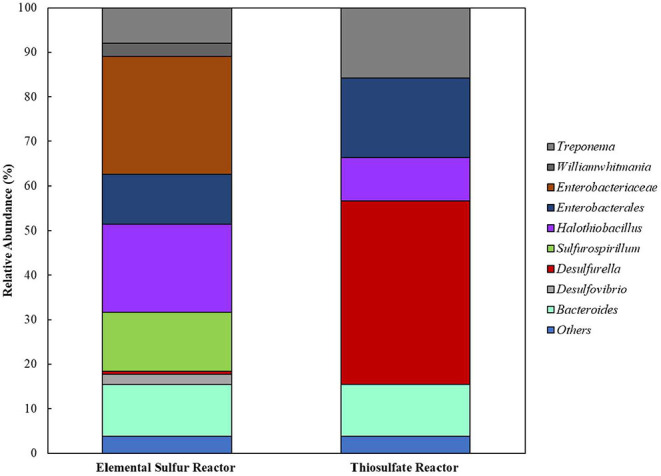
Bacterial diversity in the reactors oxidizing oleate with elemental sulfur or thiosulfate as electron acceptors. OTUs with <2% sequence reads were combined in the group “Others”.